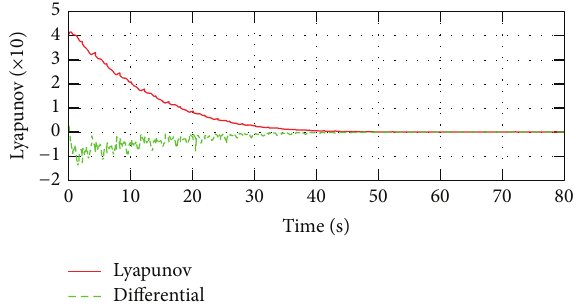
Figure 11: Time evolutions of the values of Lyapunov’s function 𝑉 ̇𝑉 and its differential .